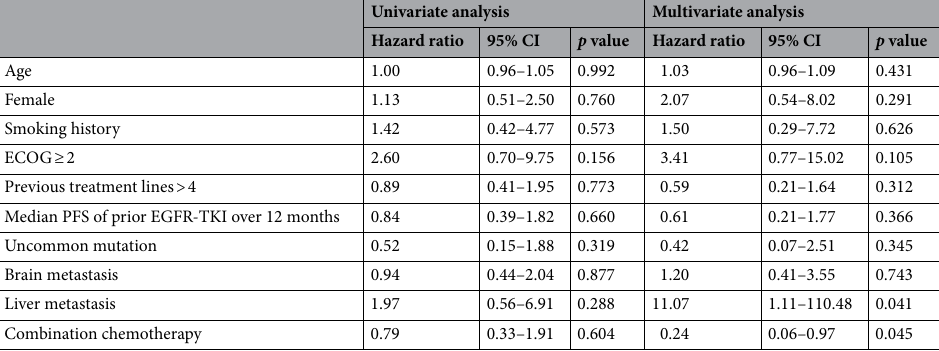
Table 2. Cox regression of factors related to PFS (n= 30).